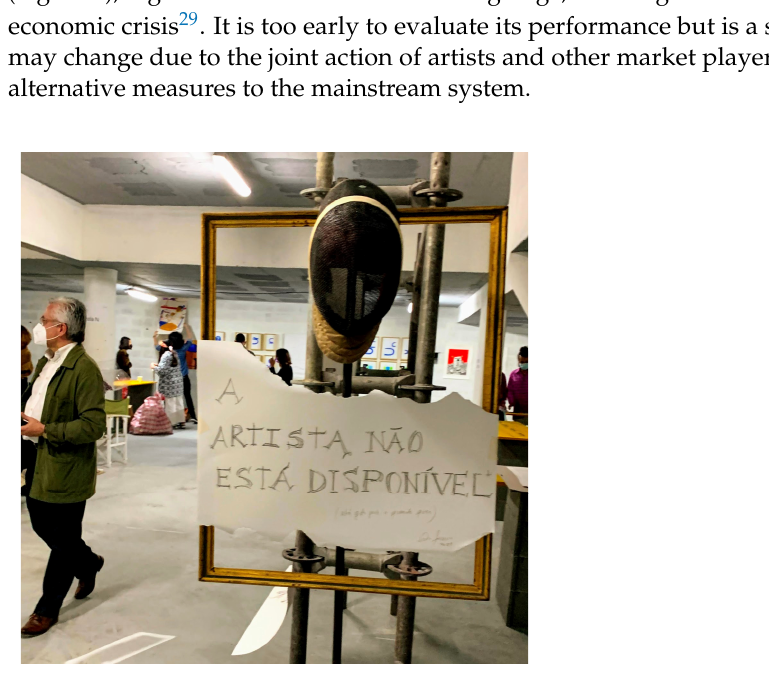
Figure 6. Mercado P’la Arte. 2021© Created by author, with permission of the artist Ana Fonseca.